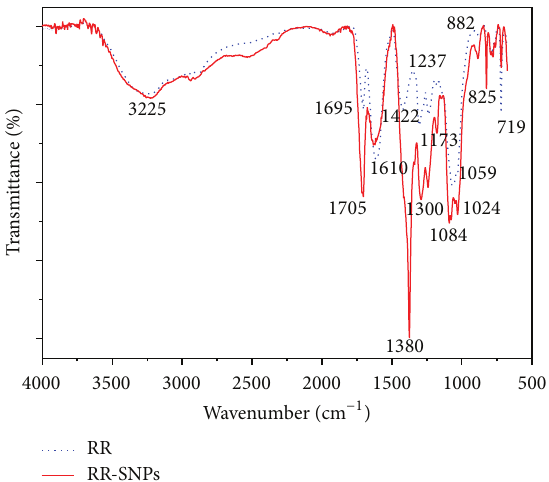
Figure 3: FTIR spectra of freeze-dried powder samples of RR and RR-SNPs.